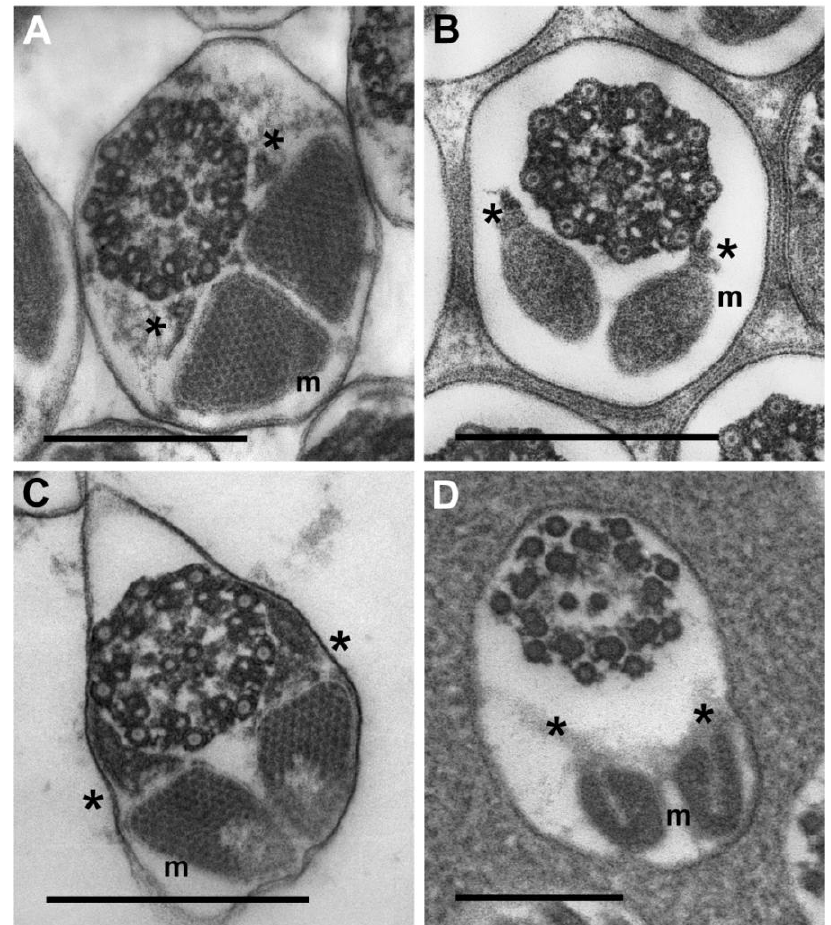
Figure 5. High magnification images of beetle and strepsipteran axonemes, mitochondrial derivatives and accessory bodies. These transverse sections of flagella are aligned so that mitochondrial derivatives (m) lie at the bottom in each image; axonemes lie at the top. Positions of distinct accessory bodies in B , C or indistinct accessory bodies in A , D are marked with small asterisks. ( A ) H.scutellatus (Meloidae, Meloinae) . ( B ) Z. flava (Meloidae, Nemognathinae). ( C ) M. triscuspidata (Rhipiphoridae, Rhipiphorinae). ( D